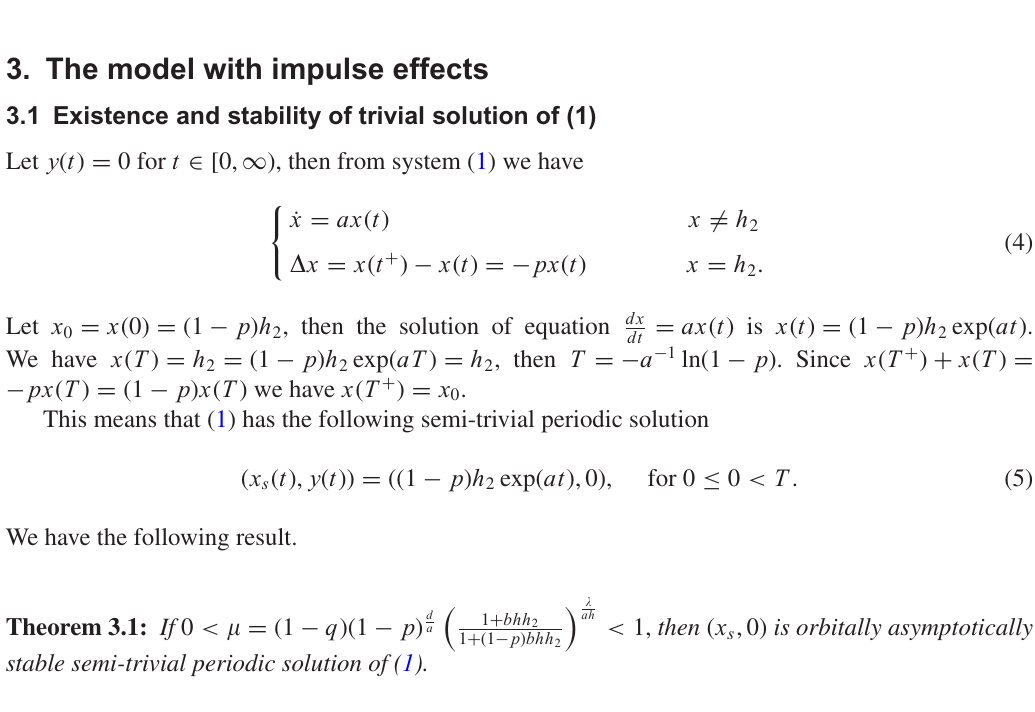
Figure 4. Periodic solutions for the prey x ( t ) and the predator y ( t ) for the Lotka-Volterra system (2) with initial conditions x (0) = 1.5, y (0) = 0.5, (cid:1) = 2, a = b = d = h =